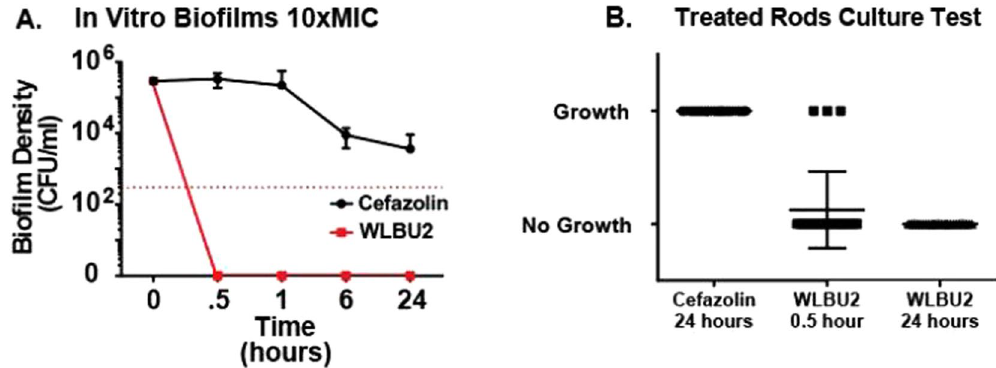
Figure 2. ( A – B ) Antimicrobial activity of cefazolin and WLBU2 against S. aureus biofilm. ( A ) Mature biofilms grown on Kirschner wire treated with cefazolin or WLBU2 at 10xMIC, CFU analysis shows cefazolin failed to clear 99.9% after 24 hours while WLBU2 sterilized Kirschner wire after 30 minutes, red dashed line represents 99.9% drop in live bacteria compared to pretreatment biofilm CFU ( B ) After CFU assay Kirschner wires placed